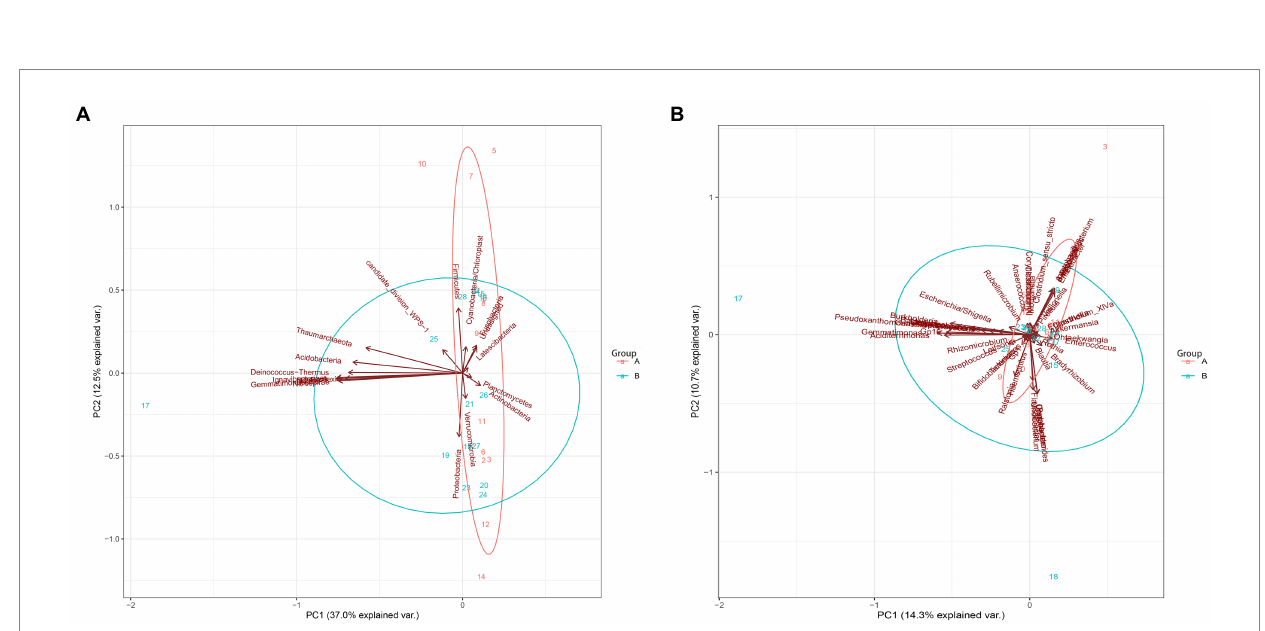
FIGURE 7 Principal component analysis between the control group and the case group at the phylum and genus levels. (A) The phylum level. (B) The genus